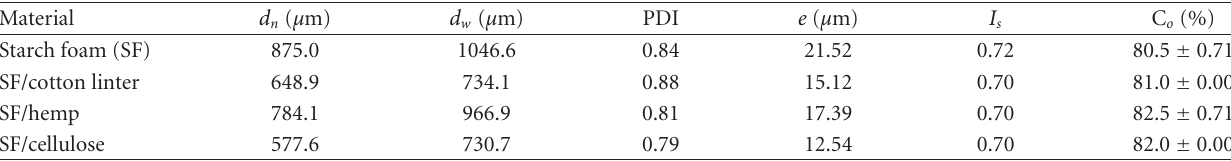
(Table 1). A tubular plasma reactor was used (gas: oxygen, power: 57 W, mass treated: 15–20 g/30 min, pressure: 0.17– 0.25 Pa, frequency: 13.56